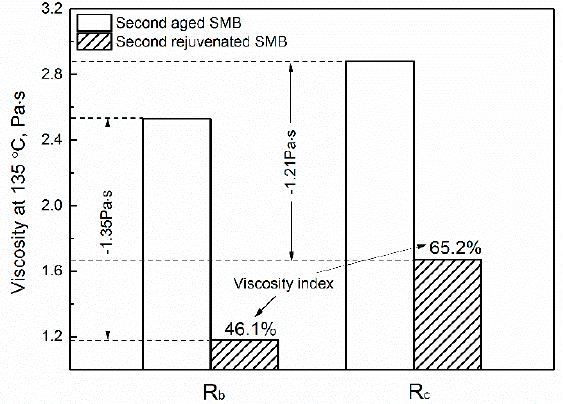
Figure 4. Effect of rejuvenating systems on the viscosity of second-aged SMB.